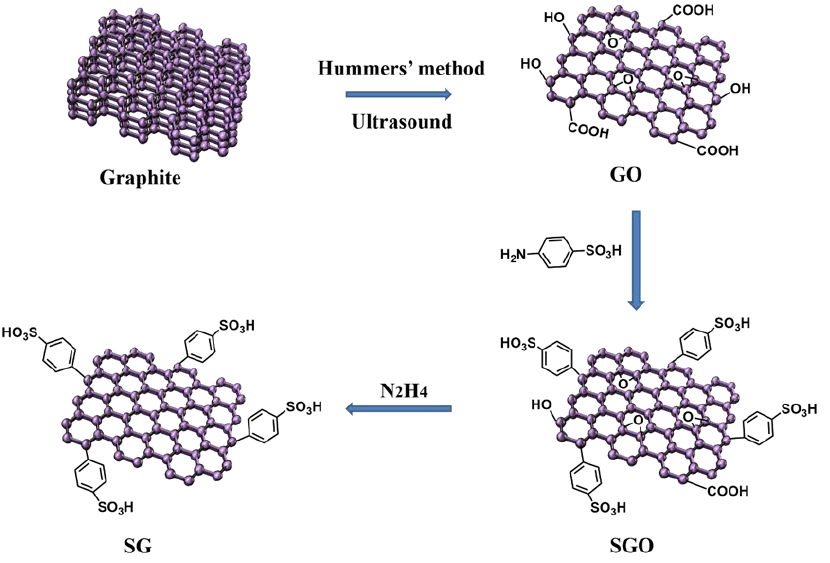
Figure 1. Schematic drawing of the synthesis of sulfonated graphene (SG).